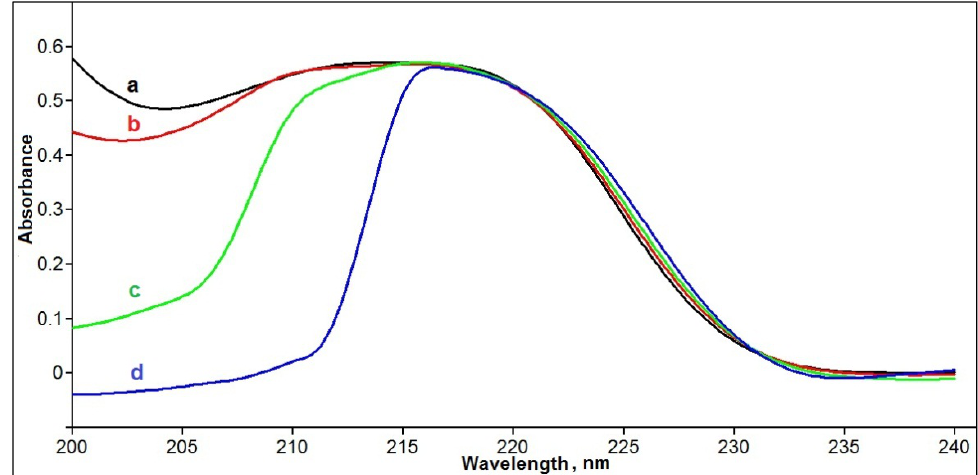
Figure 2. Effect of styrene on E concentration: 0.1 mM; styrene concentrations: ( a ) 0; ( b ) 0.1; ( c ) 0.2; ( d ) 0.4 mM. Reference cuvette contains the same concentration of styrene but no phenol.